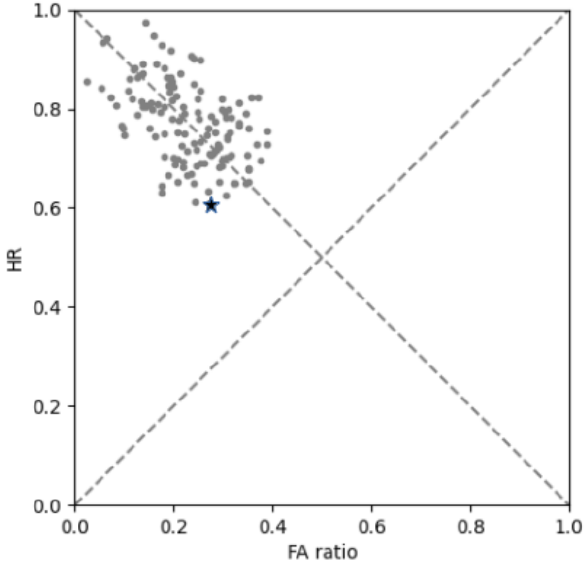
Figure 9. Pseudo ROC of the different perfect forecasts of LVP conditions defined by one observed visibility compared to the twelve observations of visibility. Each gray point represents the score of a couple of visibility measurements. The reference (P1-09R) is indicated by the star.